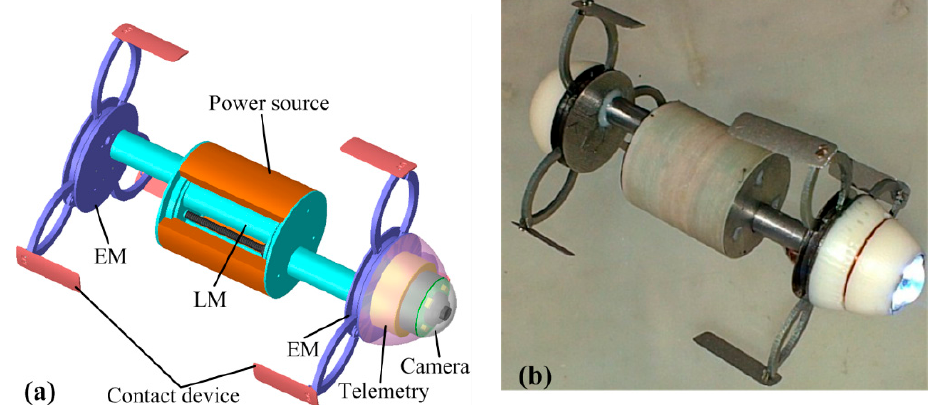
Figure 1. Design showing of the enhanced inchworm-like capsule robot (ILCR): ( a ) the CAD design; ( b ) the fabricated prototype.